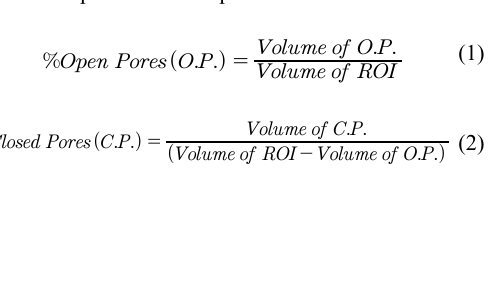
Figure 11. Pore discrimination for the 4X lens images: (a) Segmentation of the solid phase; (b) ROI tracing the object border, stretching over holes; (c) Total pores; (d) After eliminating individual black objects surrounded by white pixels in 3D (e) Open pores; (f) Closed pores.